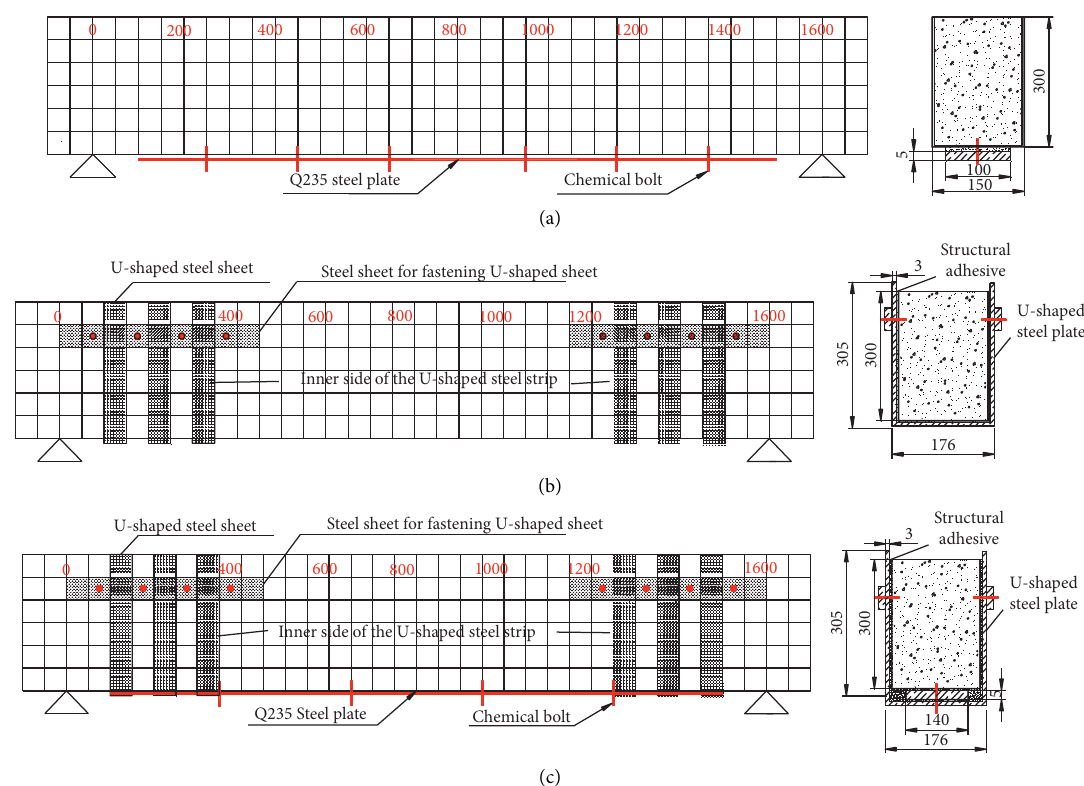
Figure 4: Schematic of strengthened beam: (a) flexure-strengthening scheme; (b) shear-strengthening scheme; and (c) combined- strengthening